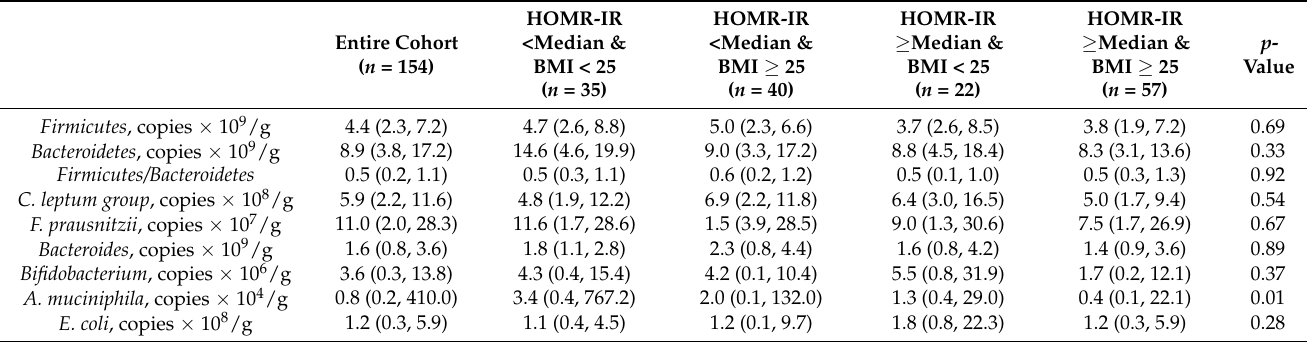
Table 2. The microbiome distribution of study participants stratified by the median of HOMA-IR and BMI of 25 kg/m 2